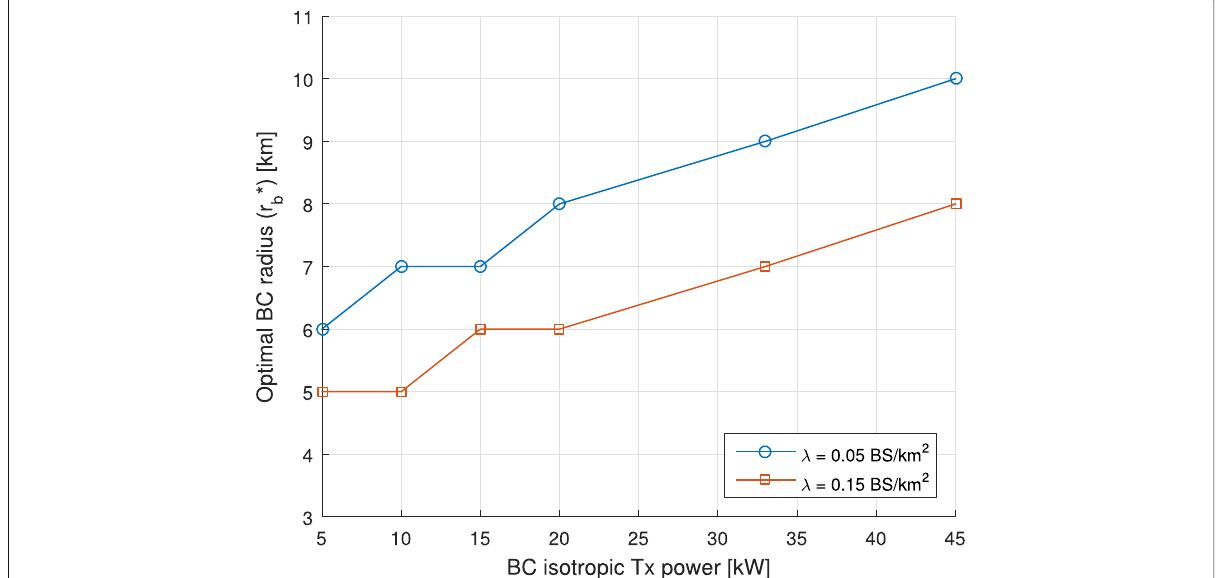
Fig. 11 The Effect of BC transmission power on the optimal BC radius in shared spectrum